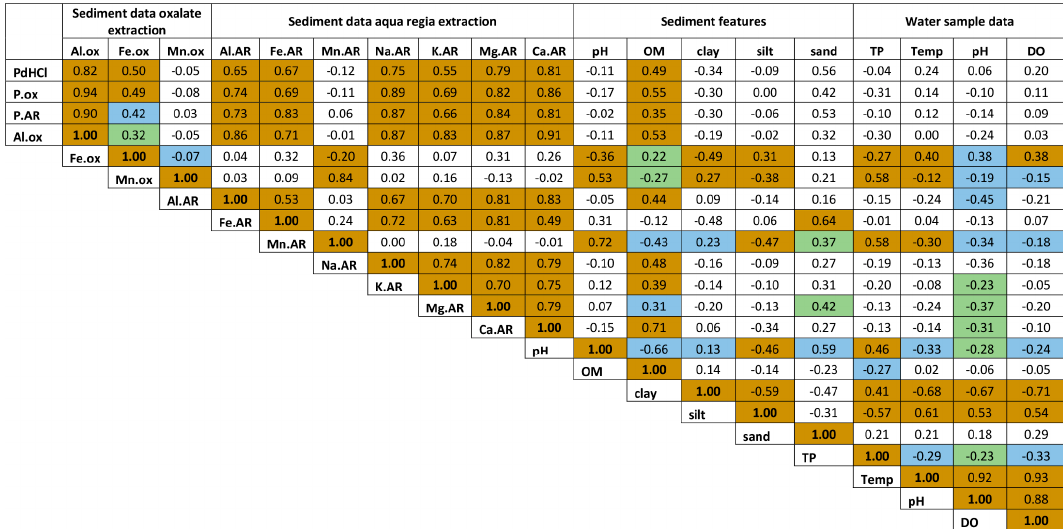
Figure 9. Spearman correlation of sediment and water data for both samplings. p ≤ 0.05 (green), p ≤ 0.01 (blue) and p ≤ 0.001 (brown), not significant (no color).